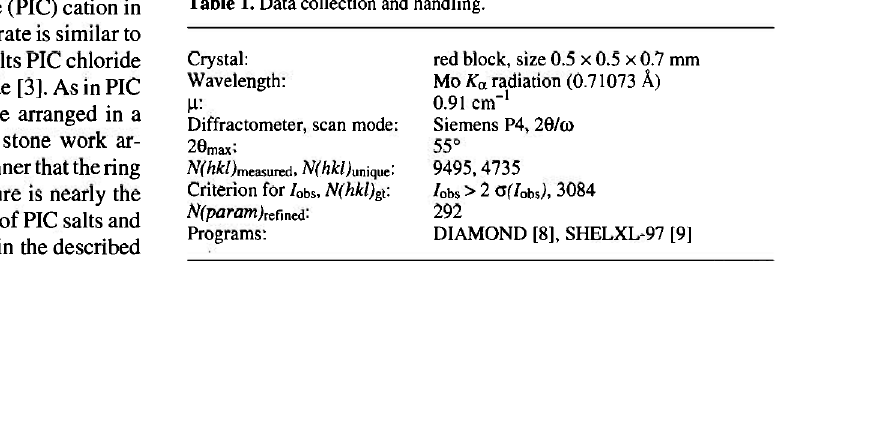
Table 1. Data collection and